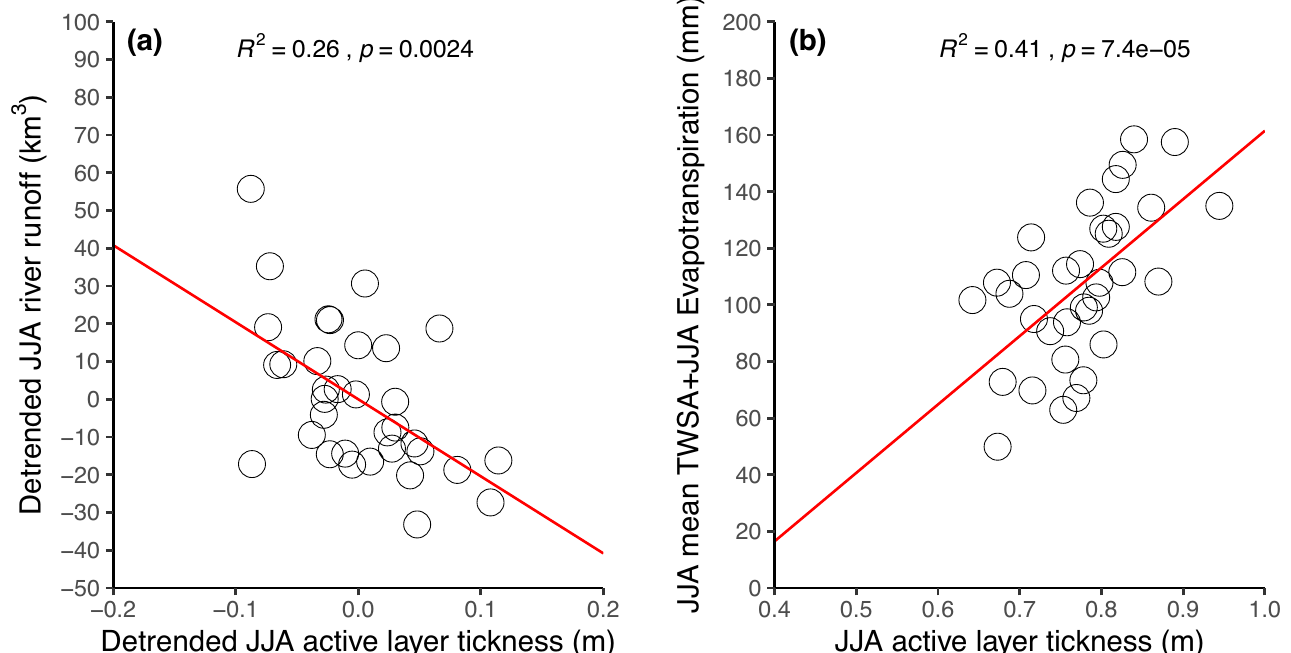
Figure 14. Relationship between ( a ) detrended June–August (JJA) river runoff and detrended JJA ALT and ( b ) Relationship between JJA TWSA and JJA evapotranspiration and JJA active layer thickness